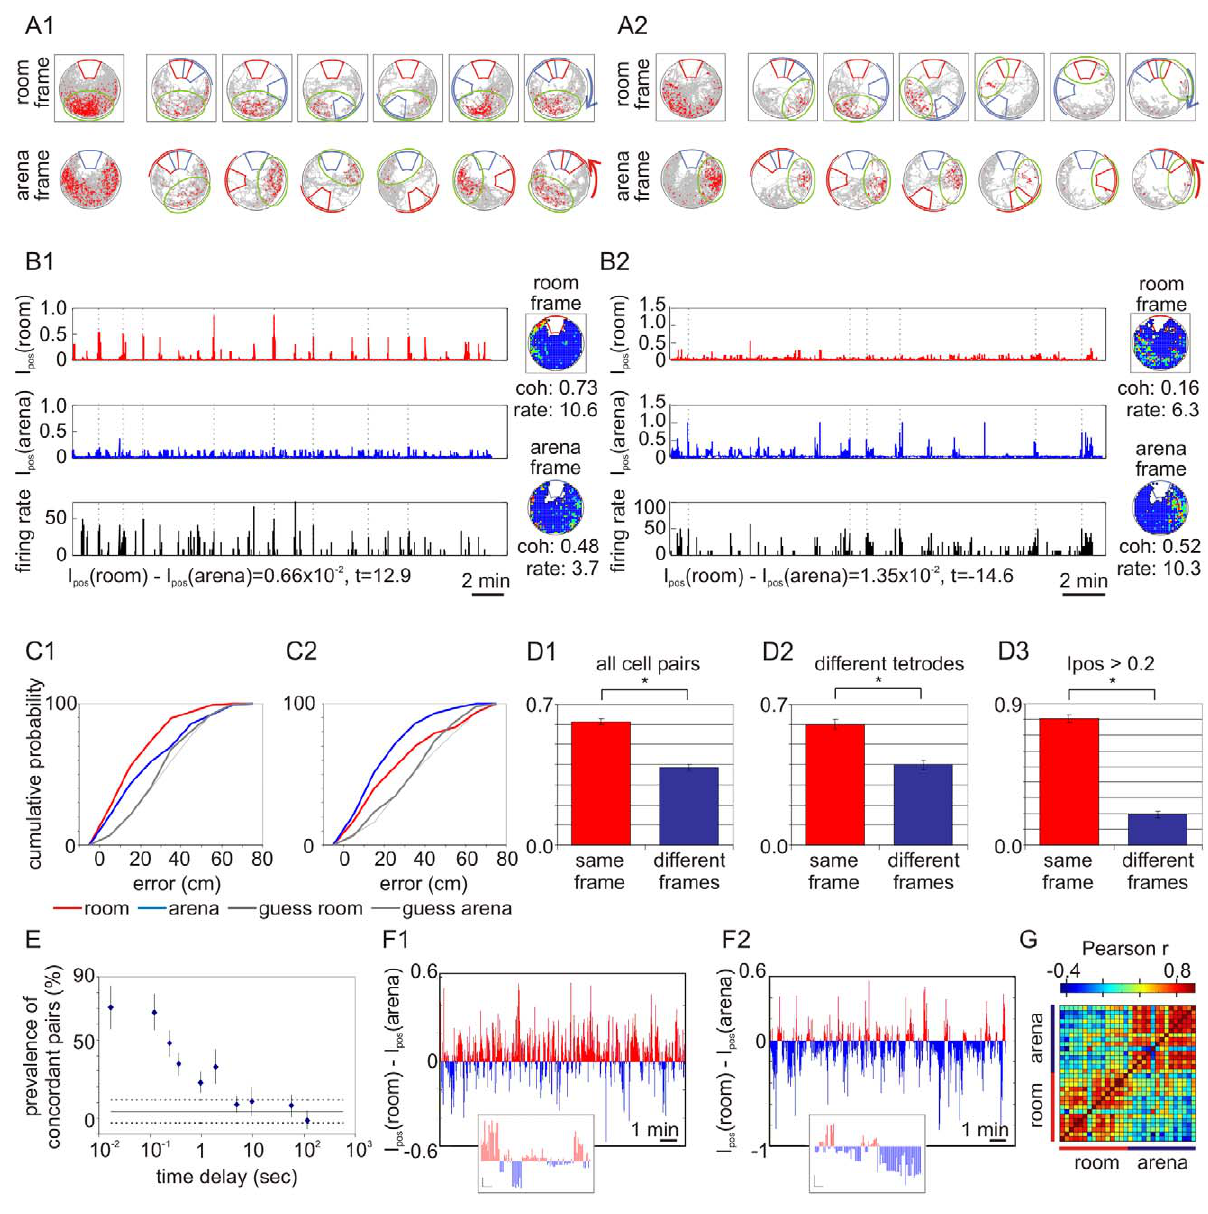
Figure 2. Coordinated frame-specific place cell discharge. (A) Spike maps of a room-preferring cell (A1) and an arena-preferring cell (A2). Frame-specific activity during the whole session is represented in the leftmost column. The other six columns represent activity during different 60 u ranges (represented by an arc) of the arena displacement during rotation. (A1) This room-preferring cell fired in the south part of the room (highlighted by the green ellipse) regardless of the arena’s orientation in the room. Both measures of spatial firing, average I pos (0.025) and coherence (0.738), were high in the room frame, but the action potentials were more dispersed across the arena causing lower I pos (0.009) and coherence (0.484) in the arena frame. (A2) This example of an arena-preferring cell had a firing field with high average I pos (0.020) and coherence (0.523) in the arena frame. The firing field (highlighted by the green ellipse) was close to the arena shock zone (blue annulus sector). If the rat was willing to visit this region, the cell fired, regardless of the arena’s orientation in the room. Firing was dispersed in the room frame, producing low average I pos (0.006) and coherence (0.162) in this frame. (B) The spatial frame preference was quantified by momentary positional information ( I pos ). The time series of I pos from a single cell in the room frame (red) and I pos in the arena frame (blue) are shown together with the firing rate (black). The firing rate maps of the cell are shown to the right for both the room and arena frames. The coherence of the rate maps is indicated, as well as the average difference of the I pos in the two frames. (B1) A room-preferring cell: Instances of high firing rate corresponded to large I pos in the room frame but not large I pos in the arena frame. (B2) An arena-preferring cell: Instances of increased firing rate were associated with high I pos in the arena frame but not I pos in the room frame. (C) Cumulative probability of errors predicting the rat’s position in the room and arena frames during two sessions of the two-frame task. Ensemble discharge predicted both room and arena positions better than chance (paired-sample Wilcoxon test C1—room: N =162, Z =6.9, p =10 2 11 ; arena: N =162, Z =3.9, p =10 2 4 ; C2—room: N =158, Z =3.0, p =0.003; arena: N =157, Z =7.2, p =10 2 12 ). While room position was predicted better than arena position in C1 ( N =162, Z =3.4, p , 0.001), C2 demonstrates the opposite ( N =157, Z =3.5, p , 0.0005). (D) Concordant and discordant discharge was examined in pairs of cells that were active in two 117 ms intervals. Concordant and discordant discharge was equiprobable when the intervals were chosen randomly. In contrast, concordant discharge was more likely when cells were coactive in the same interval (D1) even if the cells were recorded from different tetrodes implanted at least 400 m m apart (D2). The proportion of concordant discharge increased when intervals with